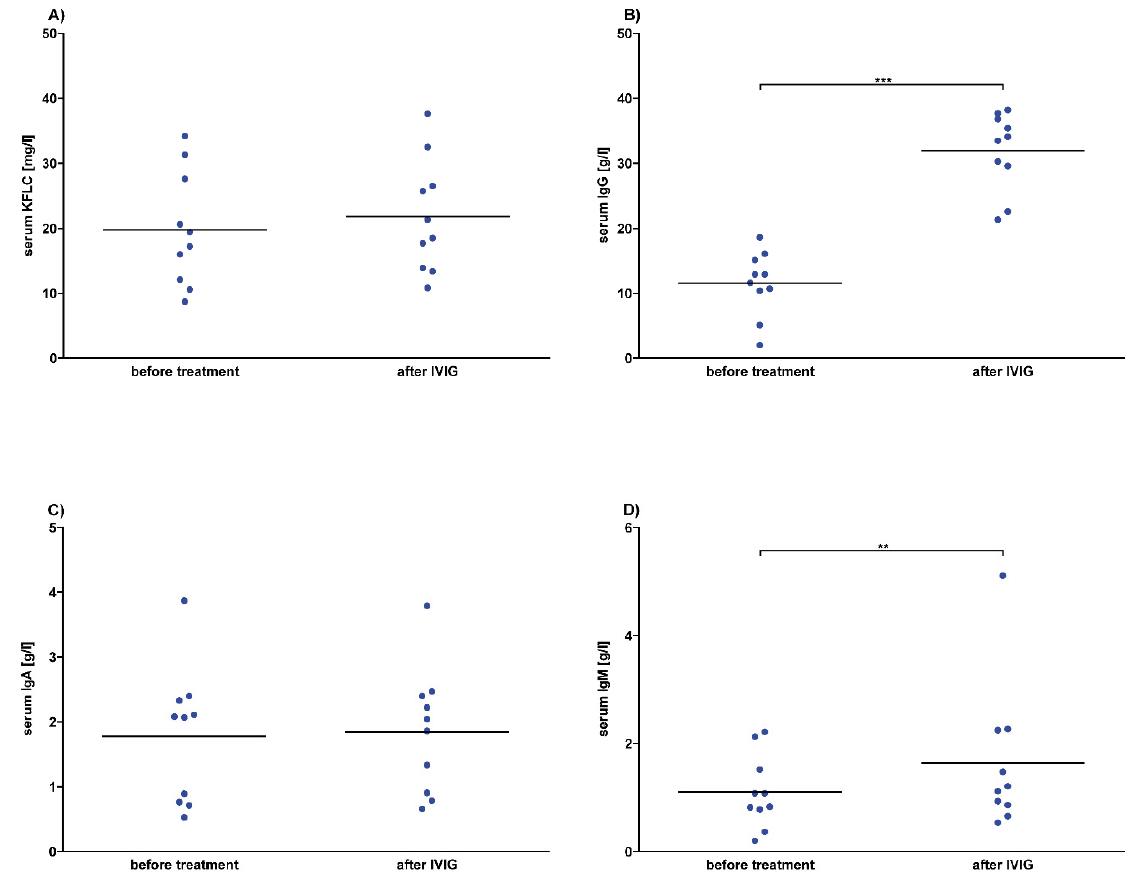
Figure 6. Serum concentrations after intravenous immunoglobulin (IVIG) in prospective patients. Serum concentrations of patients whose data and samples were collected in 2018 and 2019 are shown. Depicted are serum concentrations of kappa free light chains (KFLC) ( A ), immunoglobulin type G (IgG) ( B ), IgA ( C ), and IgM ( D ). Blood samples were taken before and after treatment with intravenous immunoglobulin in a dosage between 30 g and 40 g per day, resulting in a total dosage of 60 g–160 g (n = 10). p -values of significant differences are illustrated as asterisks.